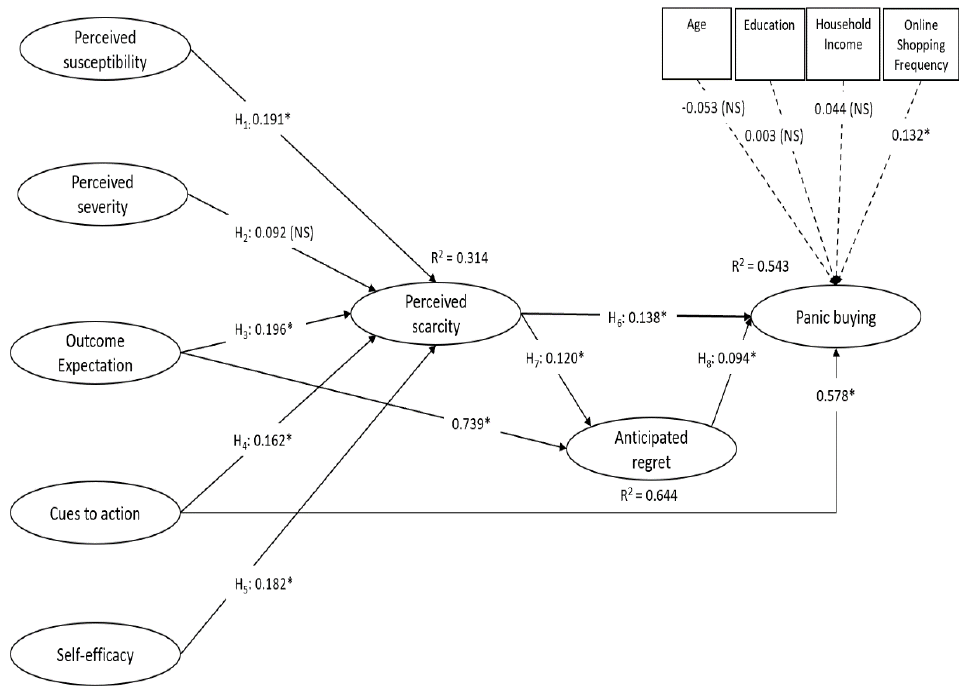
Figure 2. The proposed structural equation model after post hoc analysis. Note: * reflects that a path estimate is significant ( p < 0.050); Model fit indices: χ 2 /df = 1.975, ( p < 0.050, df = 351); CFI = 0.962; TLI = 0.956; RMSEA = 0.044; SRMR =